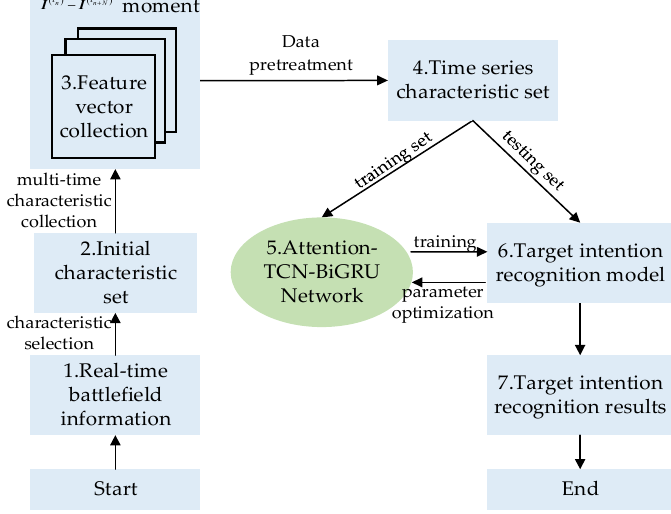
Figure 2. Process of air target tactical intention recognition.